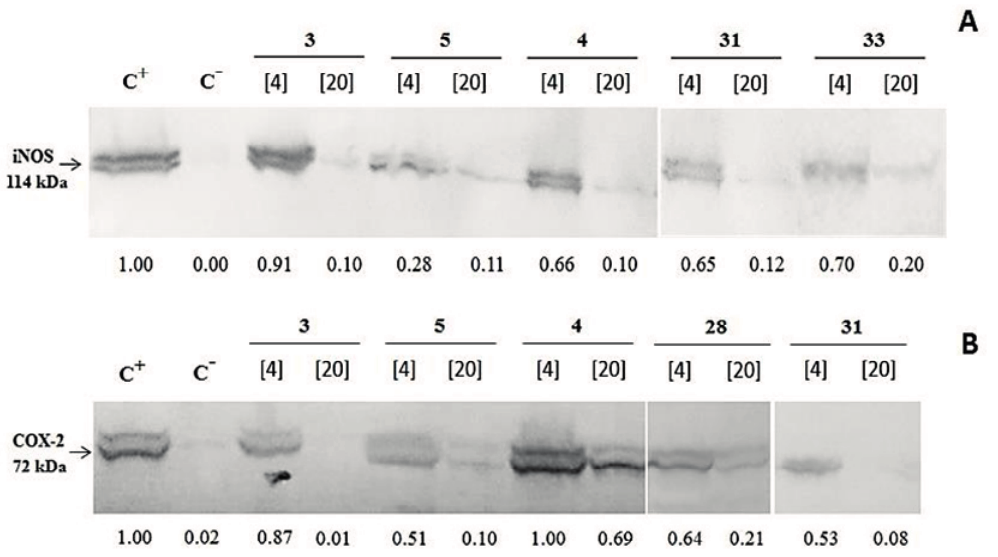
Figure 2. Effects of chalcones on iNOS and COX-2 expression following RAW 264.7 macrophage stimulation by LPS. Cells were treated with LPS (1 µg/mL) and chalcones (4 and 20 µg/mL) for 24 h, lysed and submitted to western blot for analysis of iNOS ( A ) and COX-2 ( B ) expression. The presented results refer to chalcone compounds demonstrating the highest levels of inhibitory activity levels (samples 3, 4, 5, 28, 31, 33). The cells treated with LPS only were used as a positive control of macrophage stimulation (C + ). Untreated cells were used as a negative control (C − ). Images are representative of two independent experiments that showed similar results. Lower panel, quantification of the protein levels by immunoreactive bands densitometric analysis. Each band was compared to respective positive control band at same membrane. Relative densities were calculated employing ImageJ software. Densitometric protein bands analysis was performed using ImageJ software for Windows (NIH, Bethesda, MD, USA). The value for positive control condition (LPS-stimulated cells) was set as 1 and other conditions were recalculated correspondingly to allow ratio